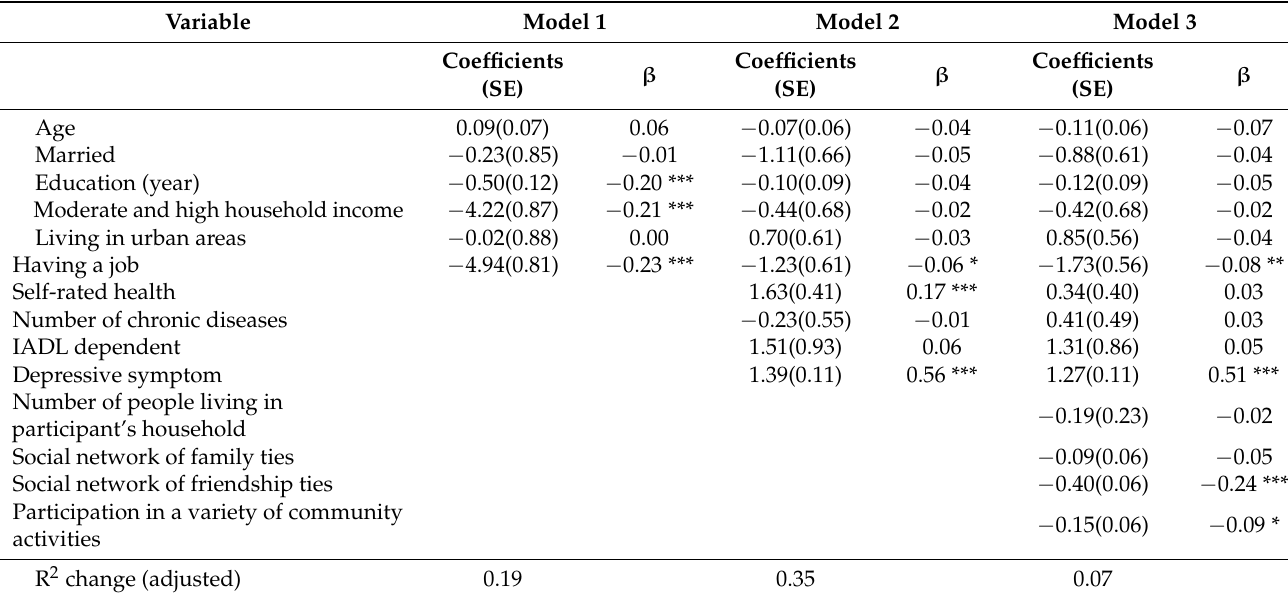
Table 4. Multivariate hierarchical regression model predicting loneliness for